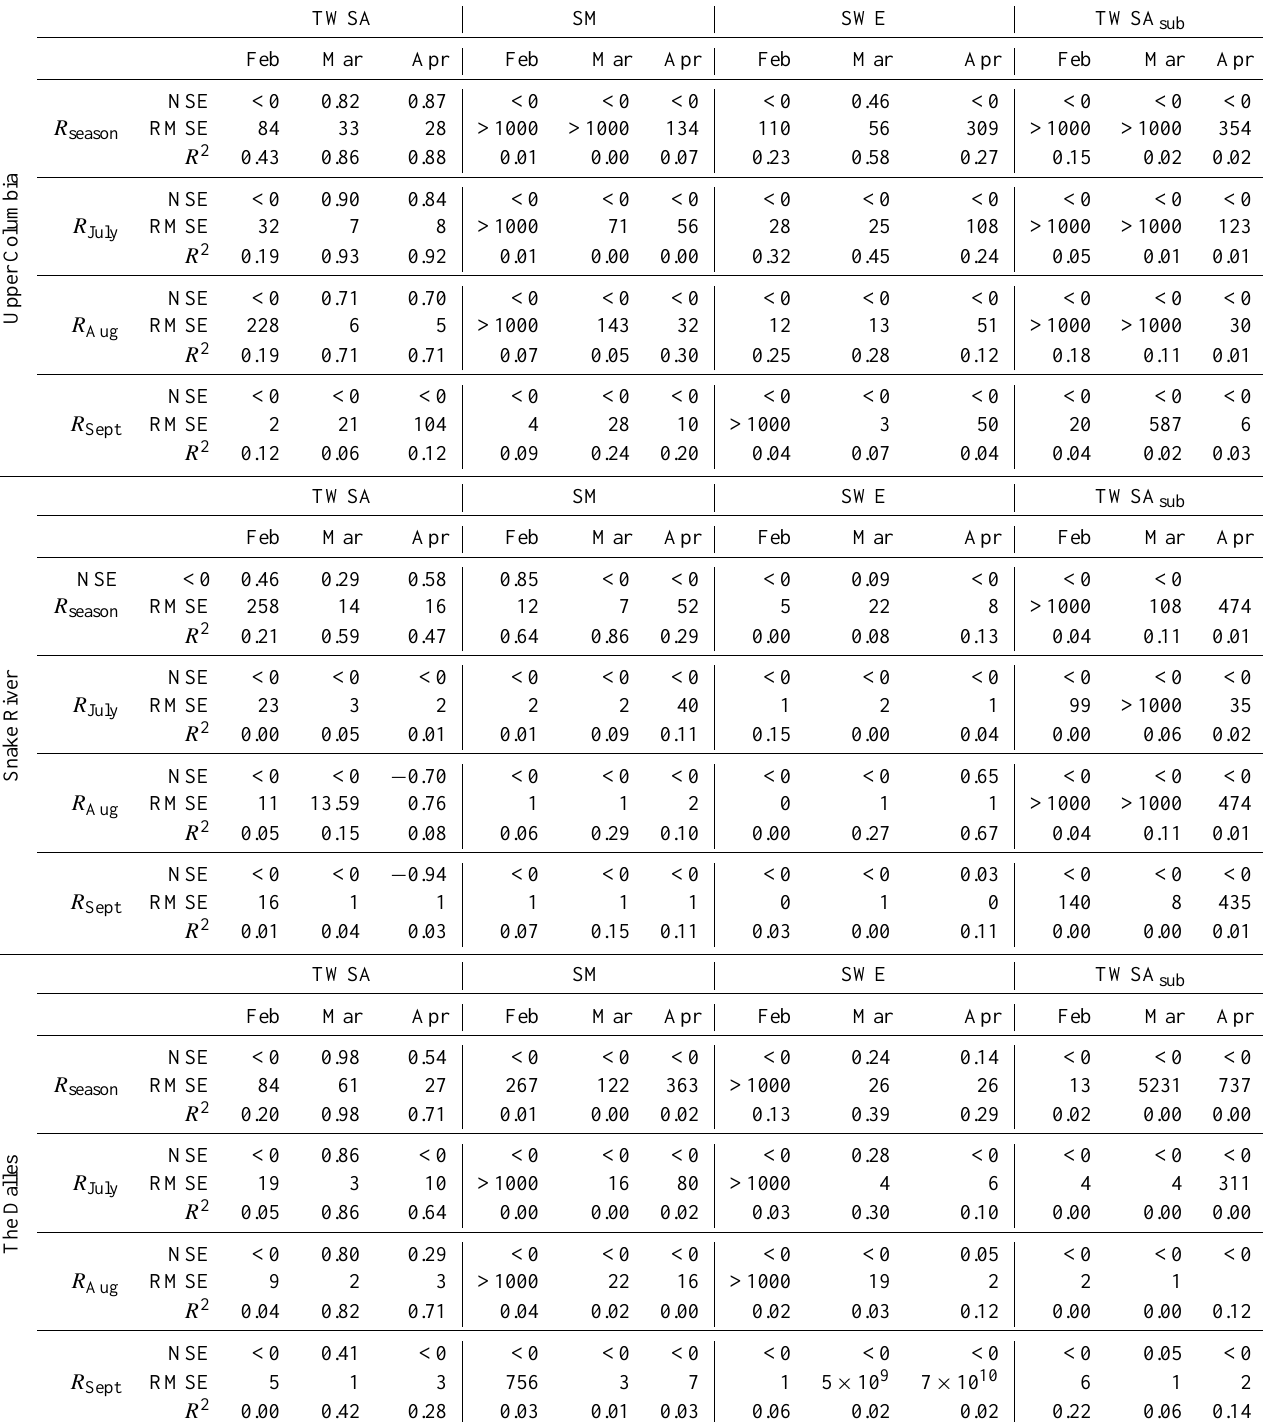
Table A3. Comparison of performance metrics using the dual-pass approach to apply GRACE TWSA, model-derived snow (SWE), soil moisture (SM), and subsurface (TWSA sub ) data in predicting seasonal ( R season ) and August ( R Aug ) runoff by watershed. RMSE values are in